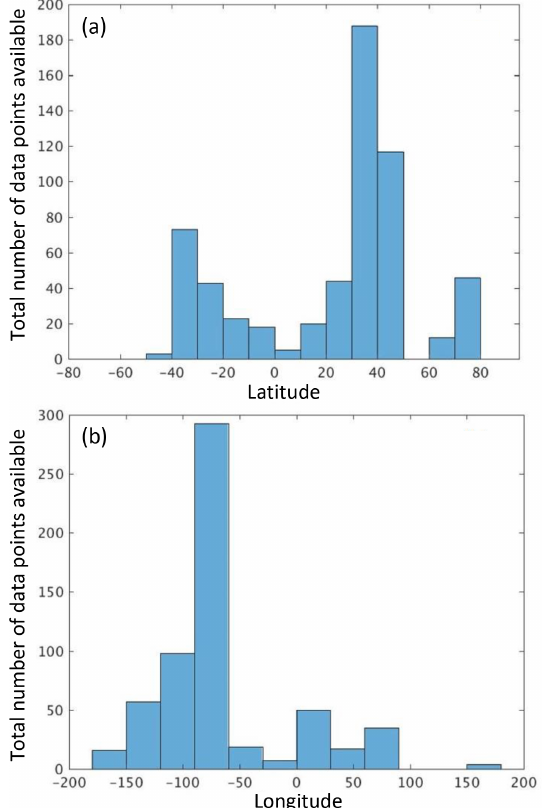
Figure 5. Geographic frequency distribution of stations with coin- cident IOP and AOP data. Panel (a) shows data point distribution by latitude, and panel (b) shows data point distribution by